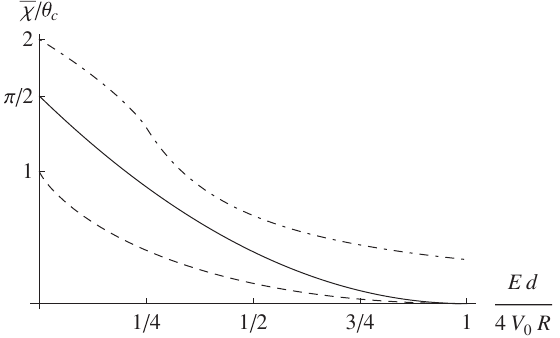
FIG. 3. Mean VR angle dependence on E=R for several models for the periodic continuous potential with well depth V 0 and width d . Solid parabola, positively charged particles in a harmonic potential well [Eq. (33)]. Dashed curve, negatively charged particles in the same field [Eq. (37)]. Dot-dashed curve, the result for a square well interplanar potential, Eq.